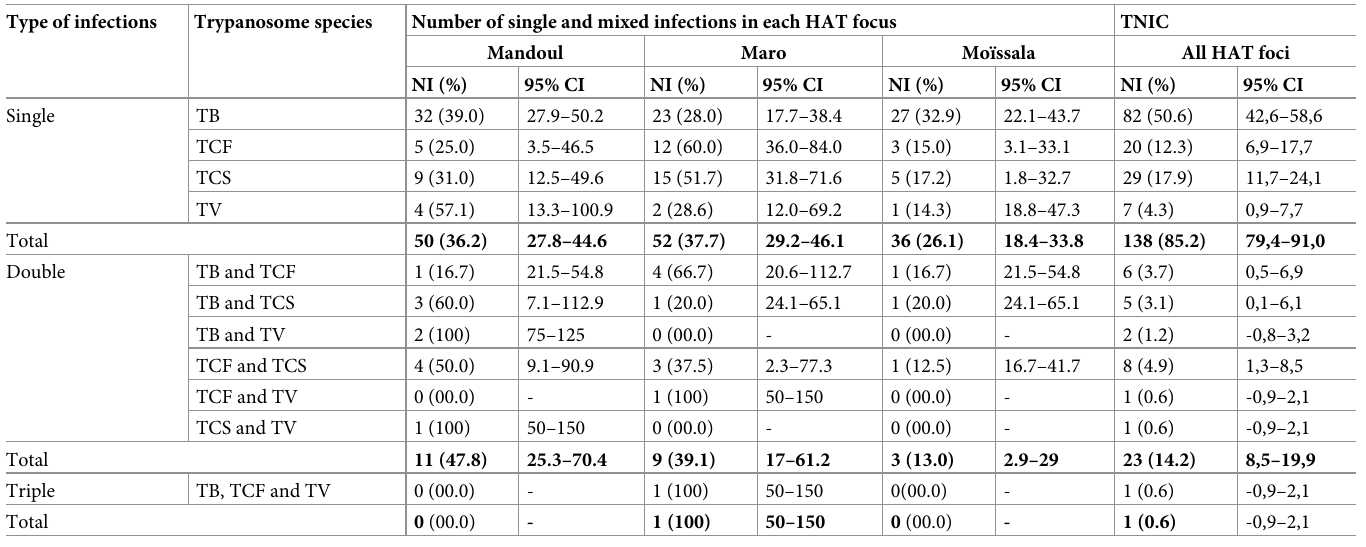
Table 3. Single and mixed infections of trypanosome species according to HAT foci. Type of infections